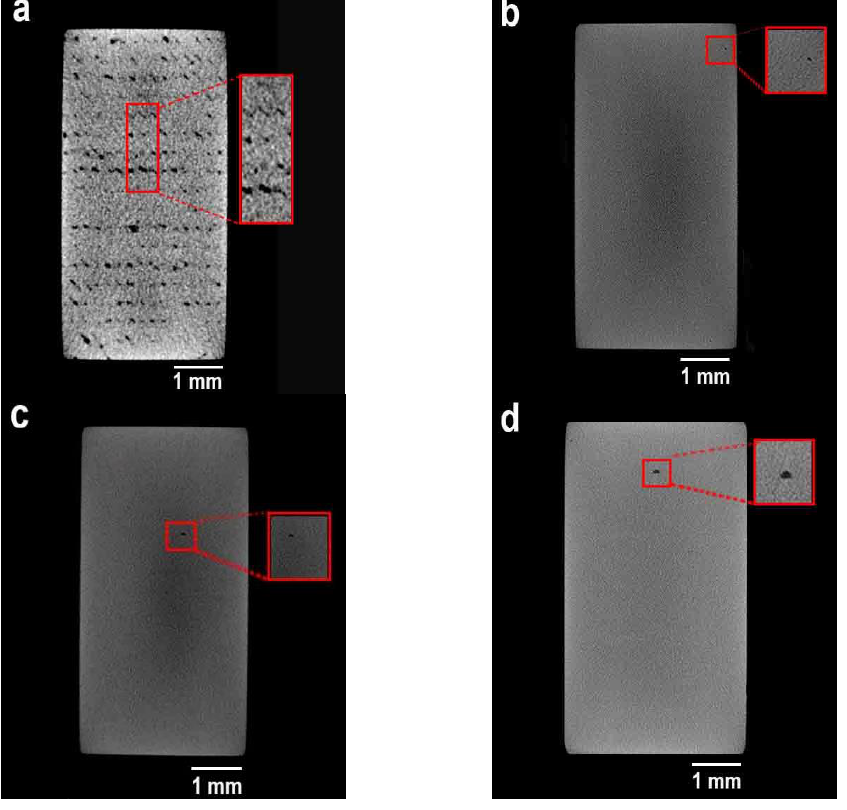
Figure 6. Representative TD images from X-ray µCT scanning of the gage length in the tensile samples for laser powers of ( a ) 160 W, ( b ) 240 W, ( c ) 320 W, and ( d ) 380 W. The resolution is 18.4 µm voxel size for ( a ) and 4.4 µm voxel size for ( b ), ( c ), and ( d ).